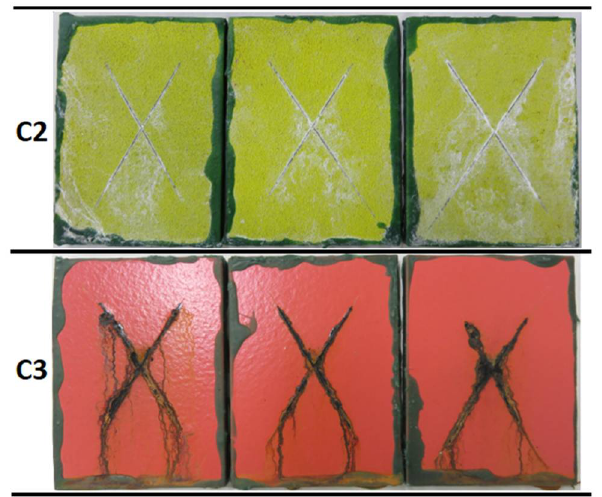
Figure 8. Visual appearance of the coatings’ surfaces without incision at different evaluations during 1440 h of exposure to salt spray, according to the ISO 9227 standard.